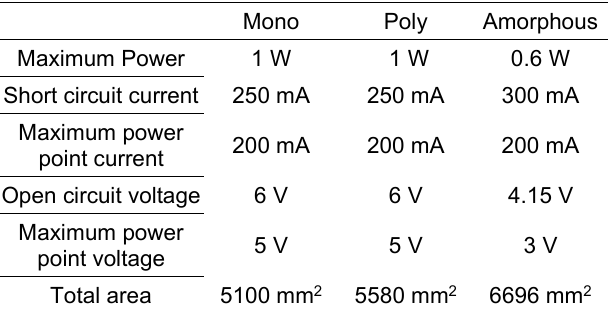
Table 1. Characteristics of the PV modules installed in the weather station.